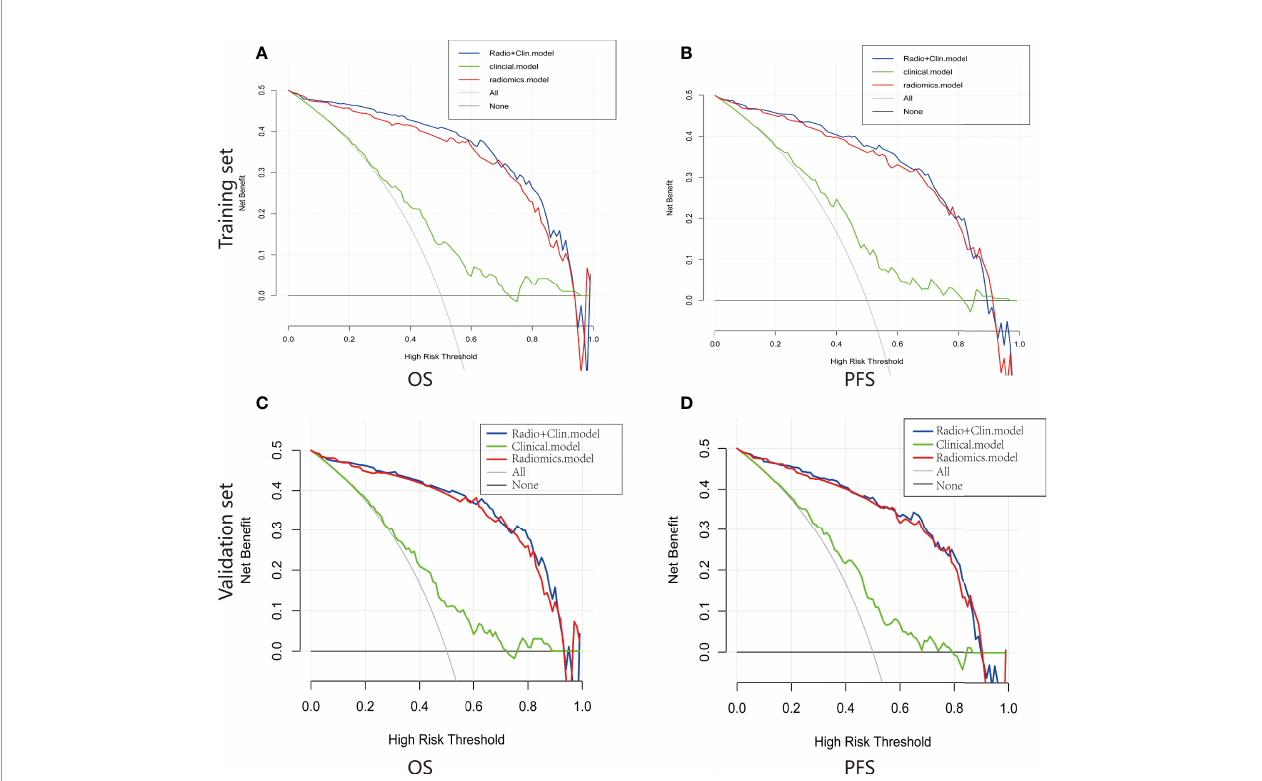
FIGURE 6 | Decision curve of the nomograms for OS (A) and PFS (B) in the training set. Decision curve of the nomograms for OS (C) and PFS (D) in the validation